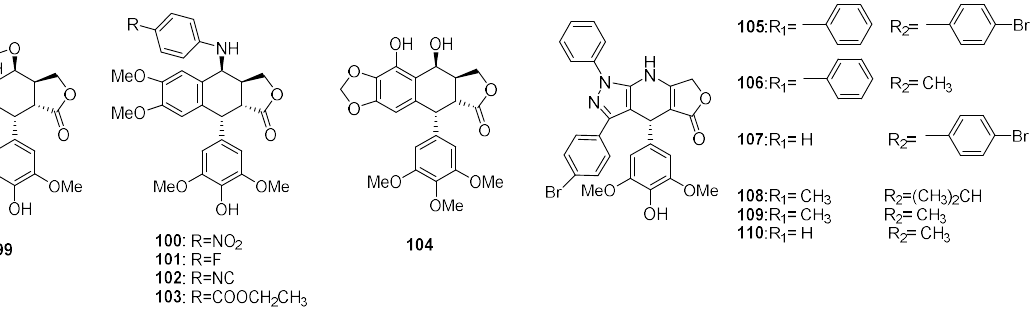
Figure 5. A-ring and B-ring modified podophyllotoxins.